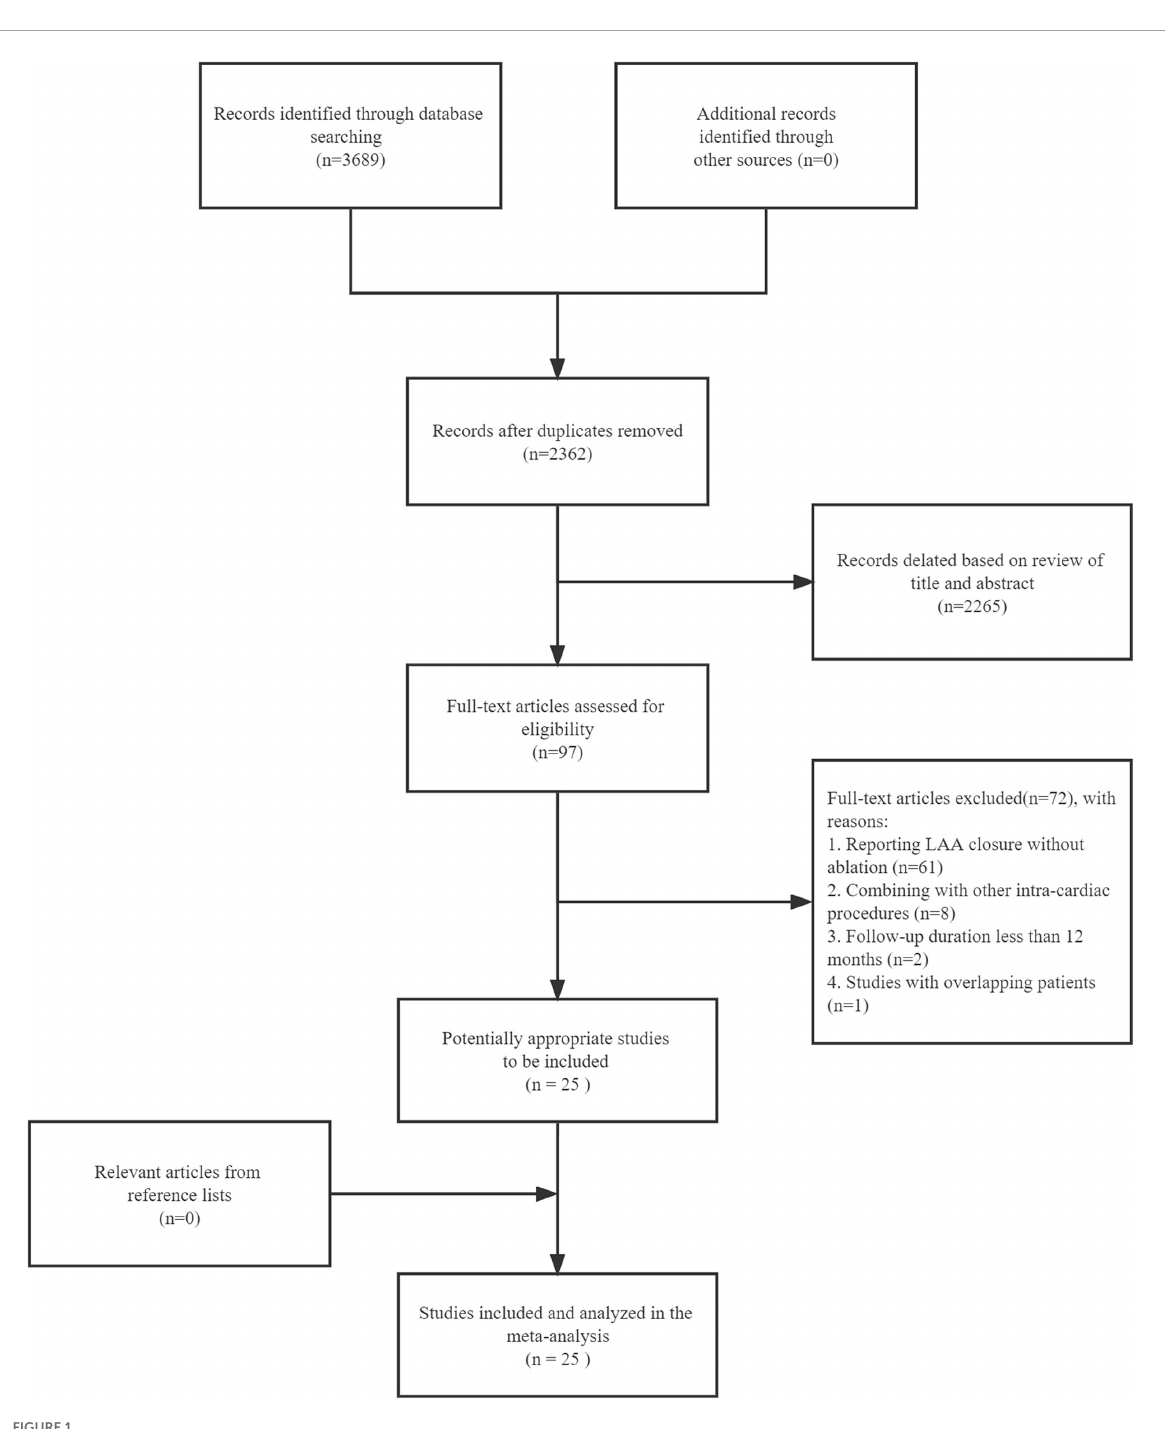
FIGURE1 Flow-chart of systematic literature search and study inclusion.